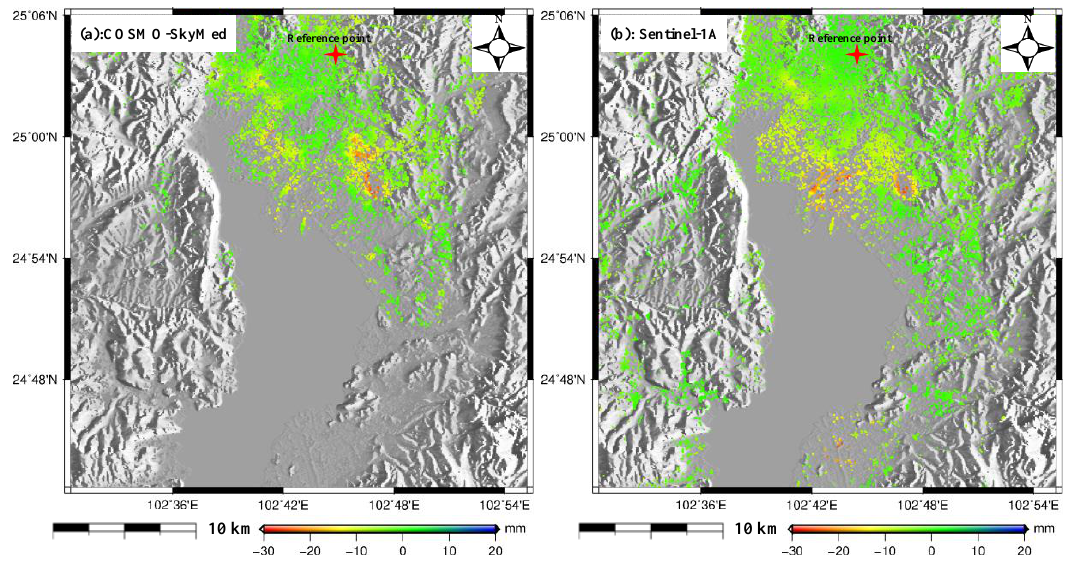
Figure 9. Comparison of deformation between the COSMO-SkyMed and Sentinel-1A datasets. The